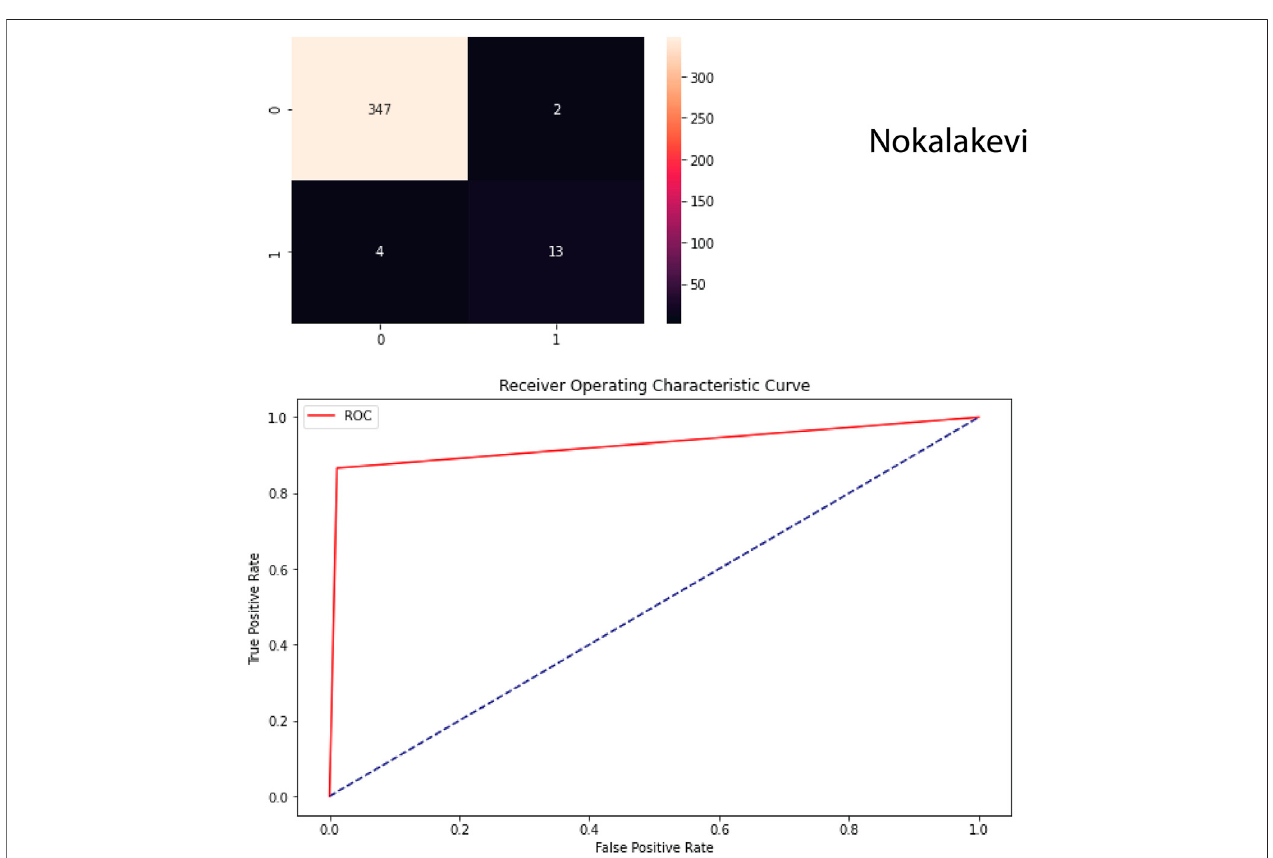
FIGURE 6 | Confusion matrix (upper graph) and ROC curve (lower graph) obtained at forecasting the next day EQs of M= > 3.5 in the area with the radius 200 km around the Nokalaqevi borehole using the previous day data. According to the confusion matrix, ML success cases amount to 12 from total 14 events with two false